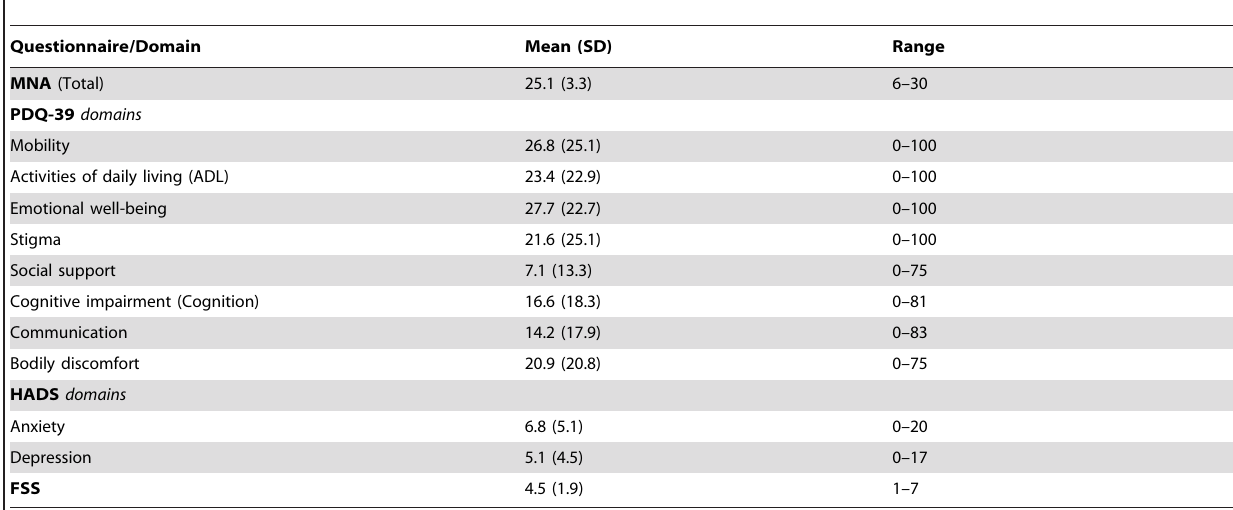
Table 2. Descriptive characteristics of nutritional status (MNA), disease-related quality of life (PDQ-39), anxiety, depression (HADS) and fatigue (FSS) in Parkinson’s disease (PD)